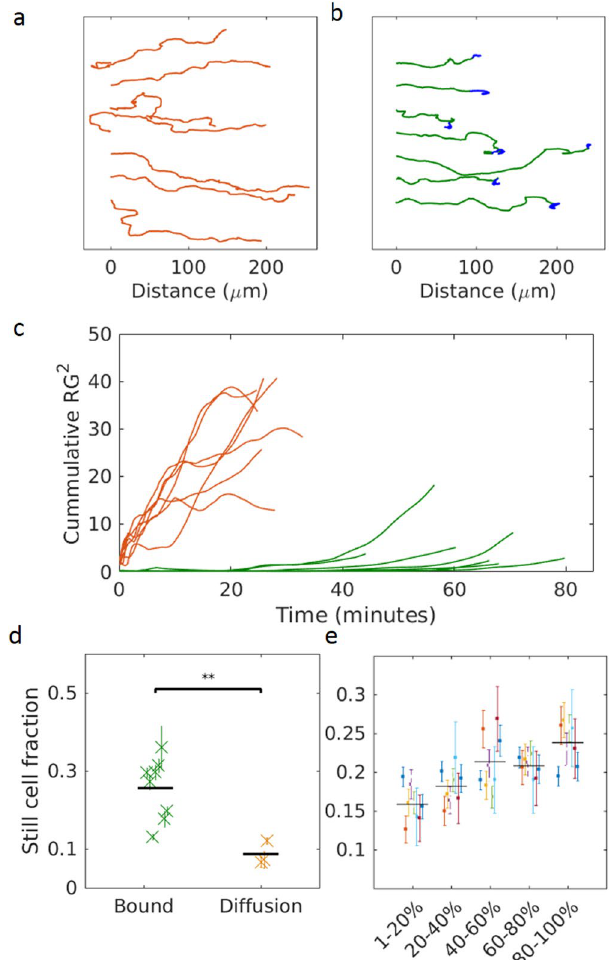
Figure 4. Comparison of migration track patterns. Representative tracks in the classic under-agarose chemotaxis assay ( a ) and substrate-bound haptotaxis assay ( b ). ( b ) The tracks are first persistent and elongated (in green), followed by deceleration and random walk around the end position (in blue). ( c ) Time-dependent evolution of the cumulative squared radius of gyration. Time 0 corresponds to the end of the track. Color coding is the same as in ( a , b ). ( d ) Fraction of total tracks showing dual behaviour (n = 3 for chemotaxis, n = 8 for haptotaxis assay). * p = 0.0065 (Student’s unpaired t-test). ( e ) Fraction of still cells in binned regions of gradients (n = 8 experiments). Colors represent individual